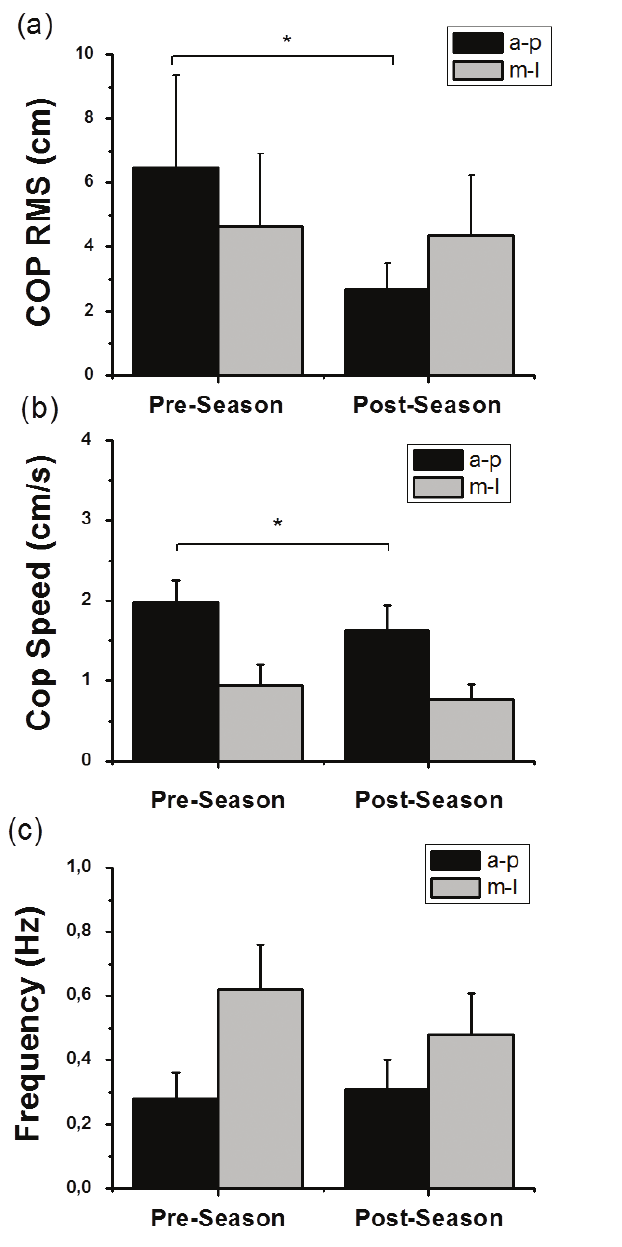
Figure 1. Mean ± SD values for pre- and post-season during bipodal quiet standing of the following analyzed variables: (a) COP RMS (anterior-posterior and medial-lateral directions), (b) COP speed (anterior-posterior and medial-lateral directions), and (c) frequency (anterior-posterior and medial-lateral directions). (* p